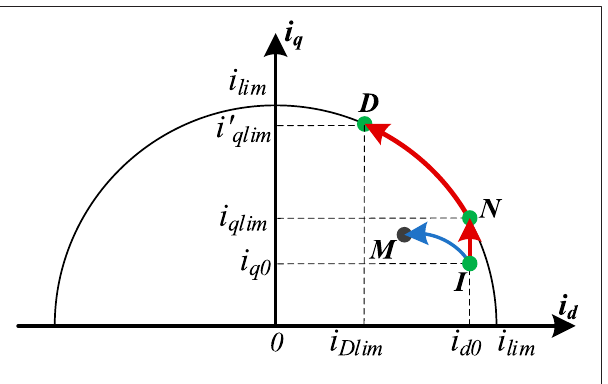
FIGURE 8 | The mechanism of the dynamic